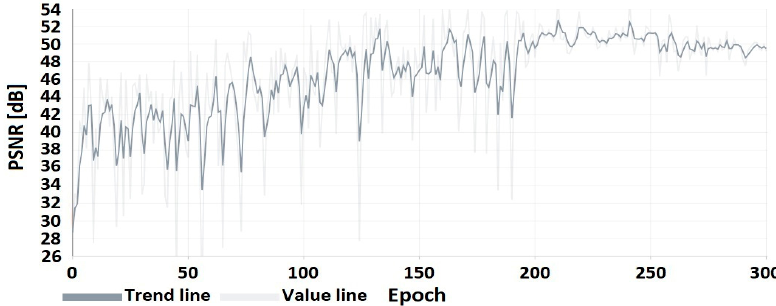
Figure 6. PSNR of the coder image (trained on CRF = 24) to the original image.